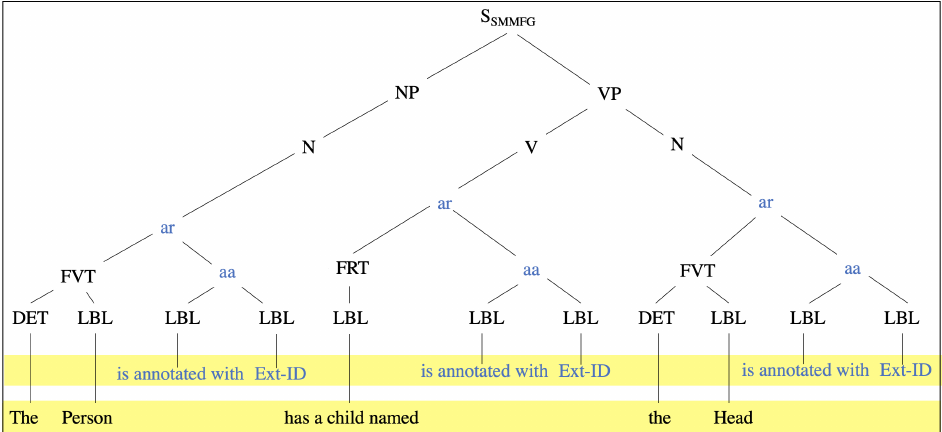
Figure 8. PS-tree with production rules, P ESMMFG , of, G ESMMFG , applied to SMMFG ex including annotation anchors.